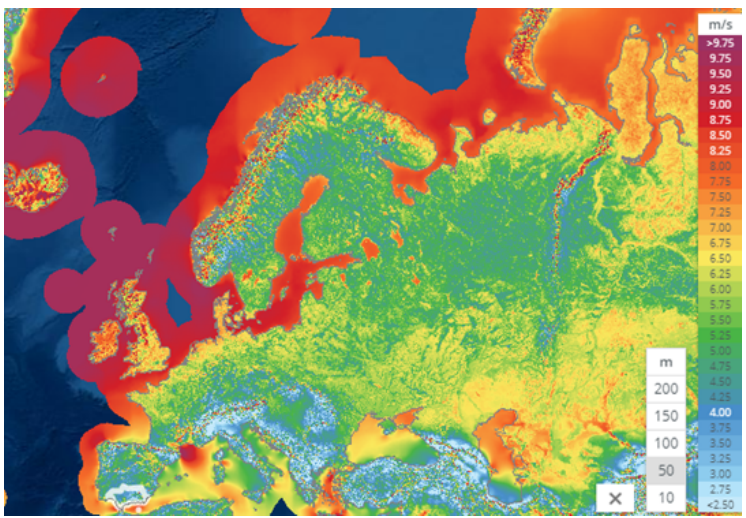
Figure 5. European wind map. Data source: